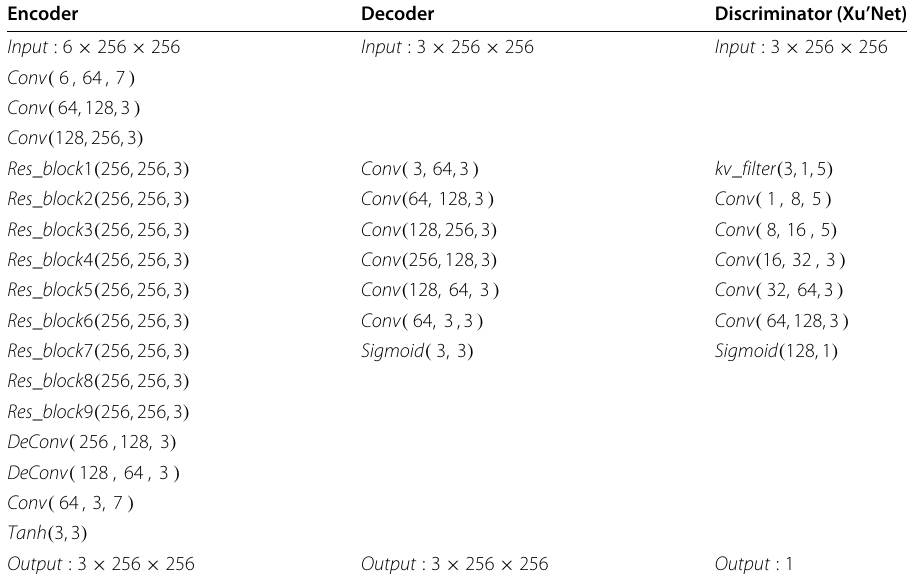
Table 1 Network architecture of proposed model Encoder Decoder Discriminator (Xu’Net)